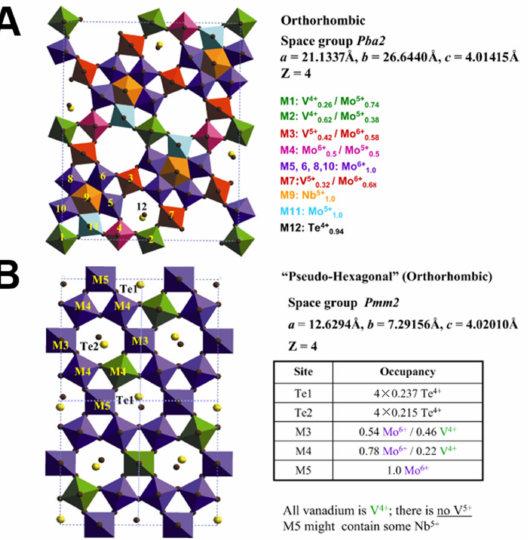
Figure 2. Scheme of ( A ) Structure of Mo 7.8 V 1.2 NbTe 0.94 O 29 (M1 phase), and ( B ) Structure of Mo 4.67 V 1.33 Te 1.82 O 19.82 (M2 phase). Adapted from ref. [42], Copyright (2004), with permission from